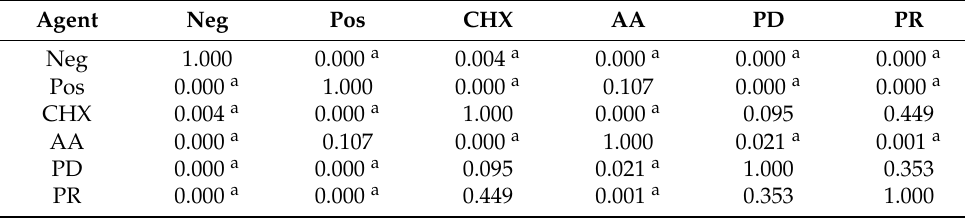
Table 4. Pairwise comparison table of antimicrobial activity on Vivera ® specimens.